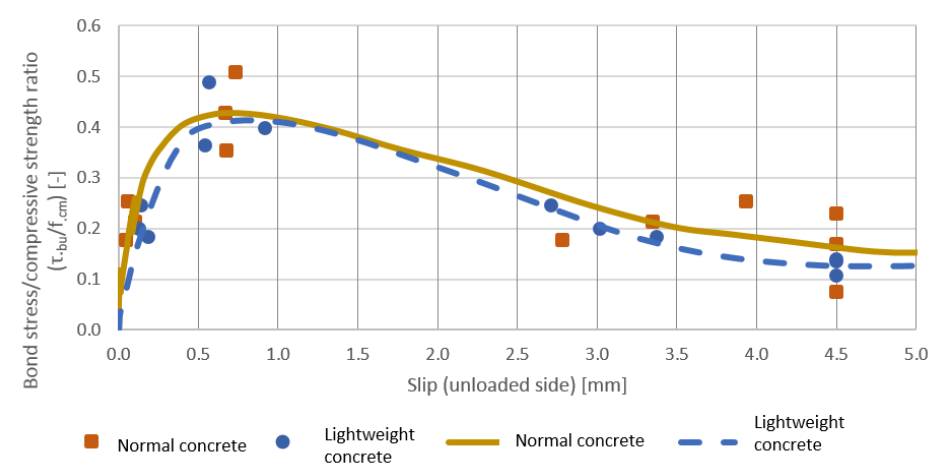
Figure 3. Bond strength ratio for normal and lightweight concrete and their average